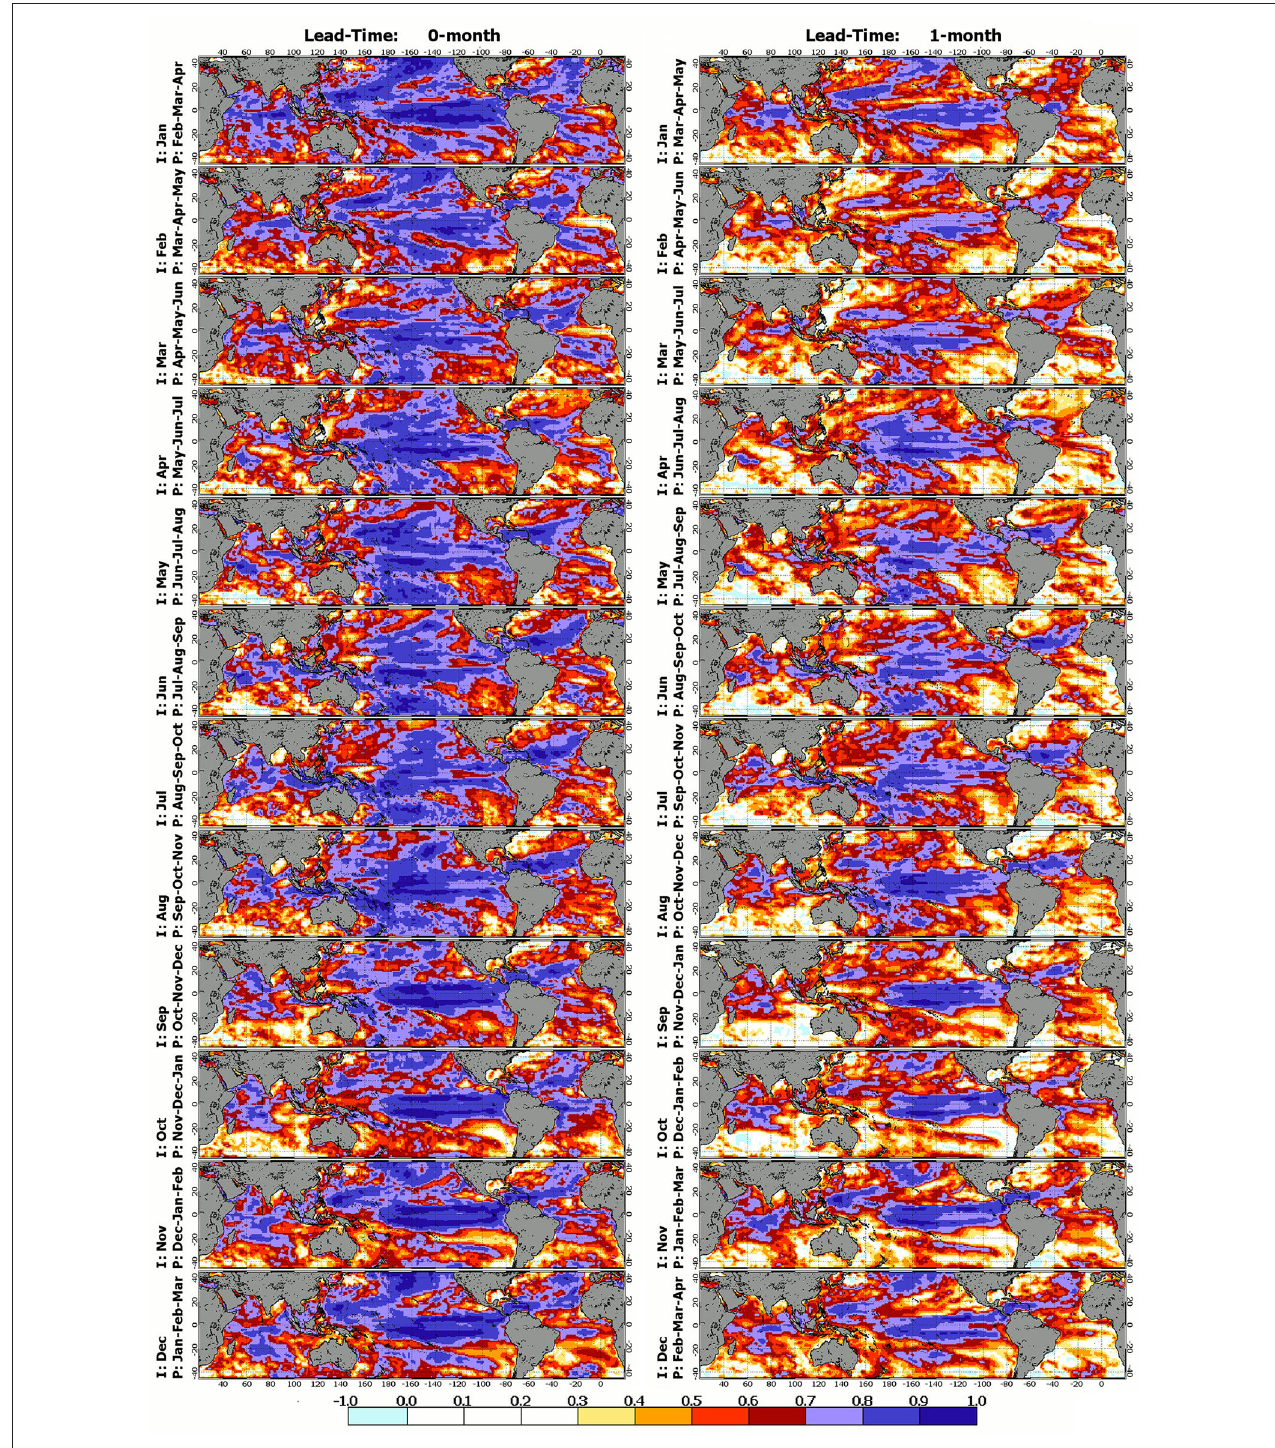
FIGURE 3 | Correlations between 1982–2009 daily CFSv2 SST hindcasts and dOISSTv2 SSTs for 12 initial condition months ( rows , January–December) and lead-times of 0- (left column) and 1-month (right column) . I: initial condition month; P: predicted 3-month period. Images reproduced from NOAA’s CFSv2 website.